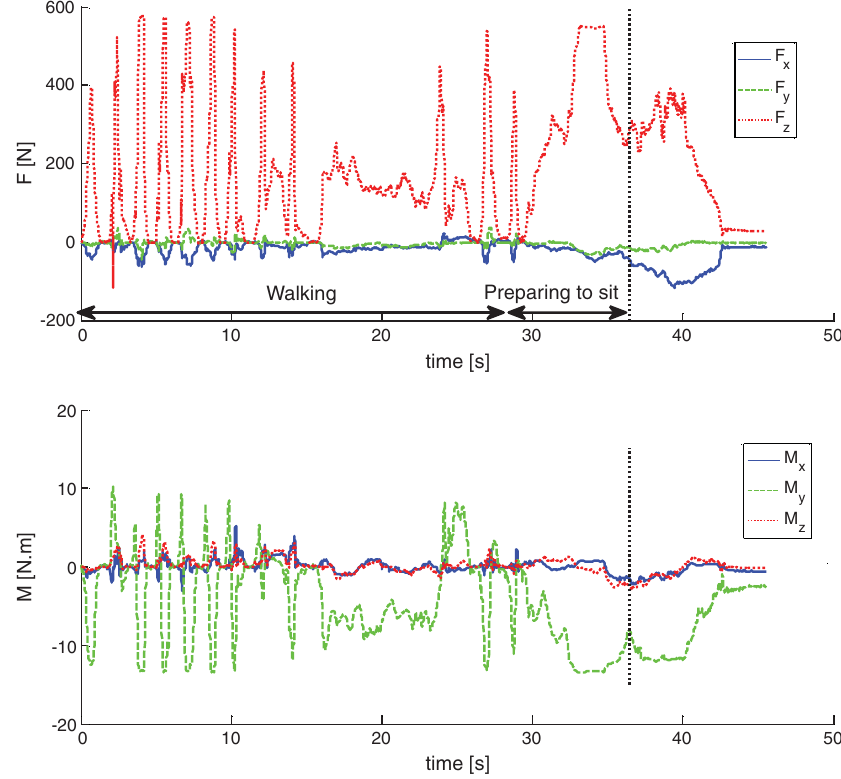
Fig. 7. Ankle force/torque sensor raw data (vertical lines indicate the instant of knee unlocking).